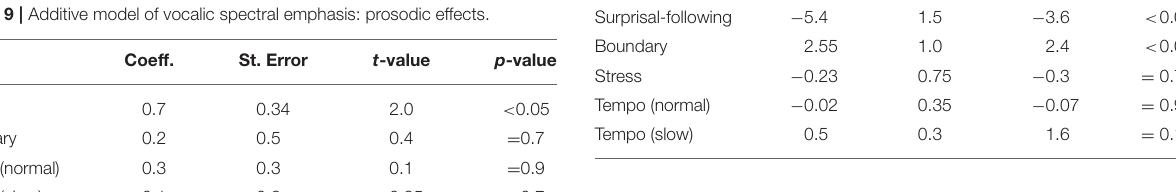
TABLE 12 | Interaction model of consonantal COG: interaction of surprisal with prosodic and place of articulation